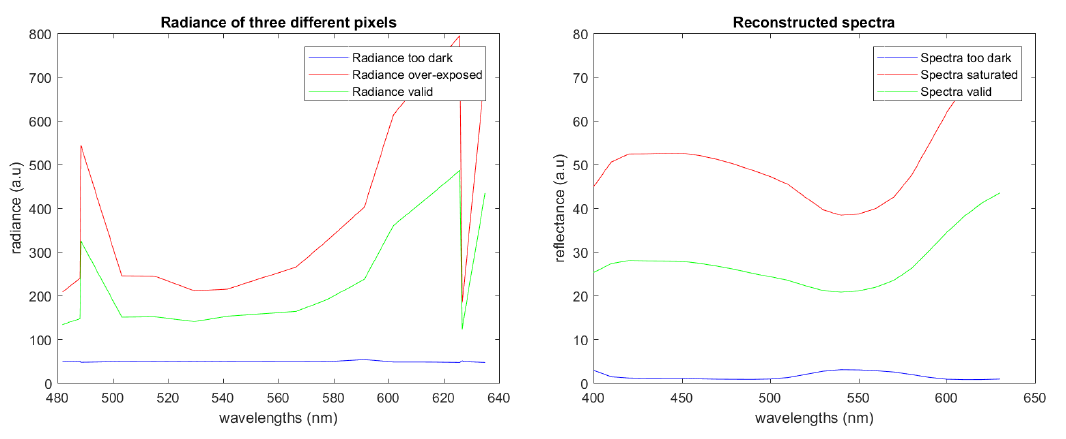
Figure 3. Example of the extraction of spectra from the multispectral